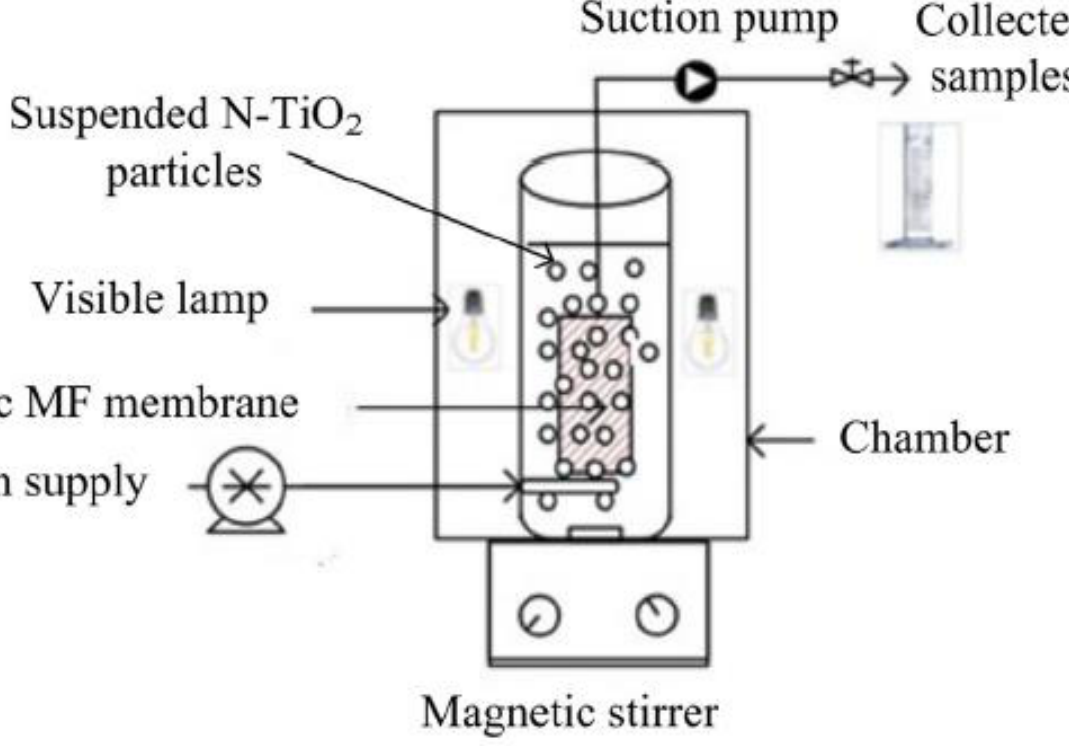
Figure 1. Diagram of submerged PMR with suspended N–TiO 2 . Reproduced with permission from [53], Copyright 2020